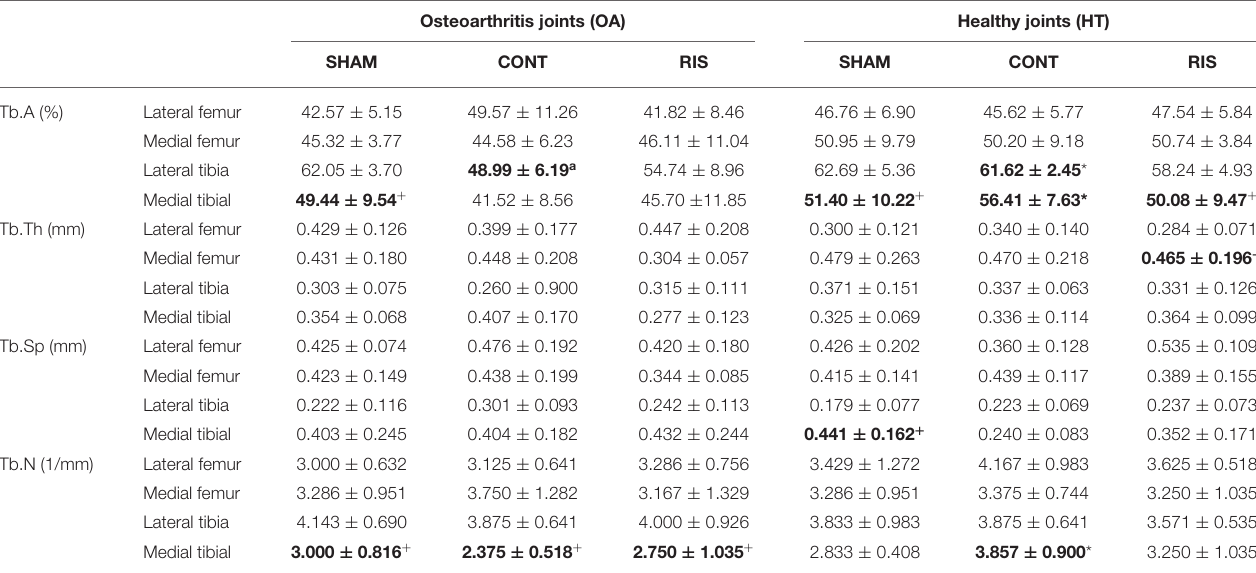
TABLE 4 | Histomorphometrical trabecular analysis of healthy and OA